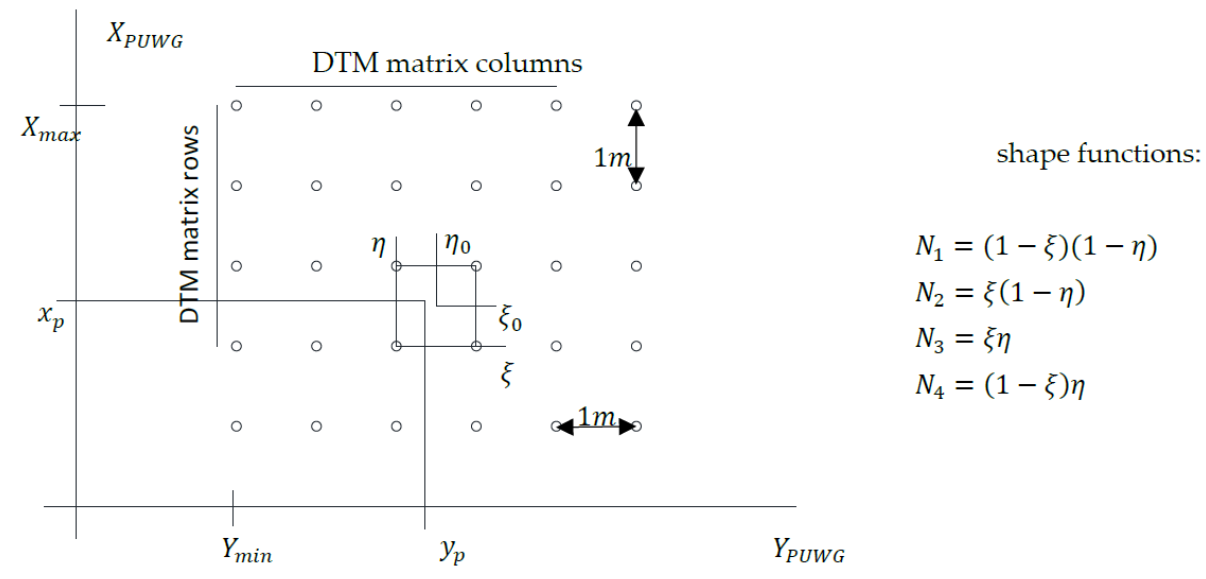
Figure 10. Lagrange interpolation.